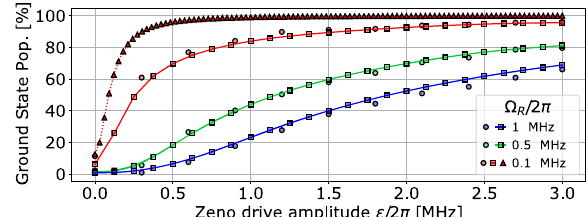
Fig. 2 Zeno blocking chance. gg j i population after starting in gg j i and Rabi driving the qutrit g j i $ e j i transition for t = π / Ω R , while simultaneously Zeno driving the cavity at ω eg , as a function of Zeno drive amplitudes ε . Circles are experimental results, squares are numerically simulated results and triangles are an ideal simulation assuming the cavity is a Markovian bath, Eq. 2 (the solid lines are provided to guide the